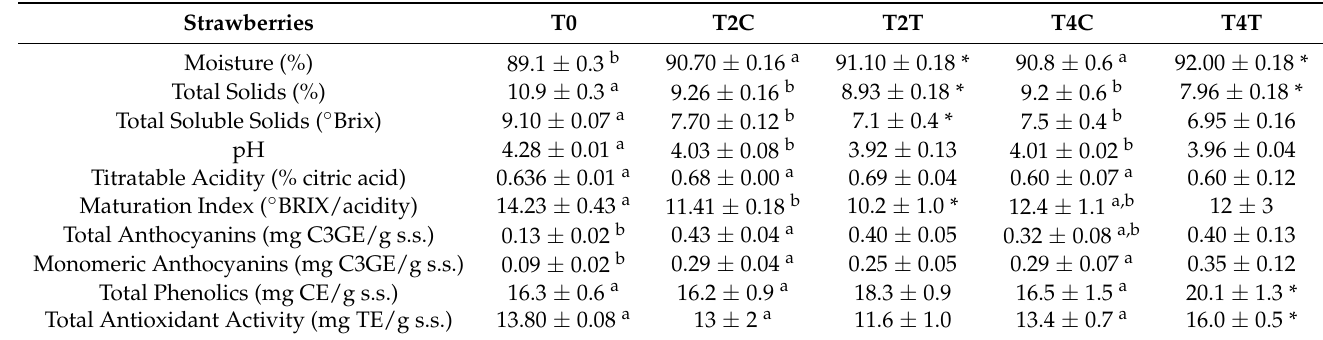
Table 5. Chemical parameters quantified in the strawberries, during the four days of storage (C = filter paper covered with 10% DMSO in PBS solution as control sample, T = filter paper covered with 10% ( v / v ) cinnamon oil). Different letters represent significant differences within each row ( p < 0.05) between the control samples. * indicates a significant difference between treated and control sample at the same time.